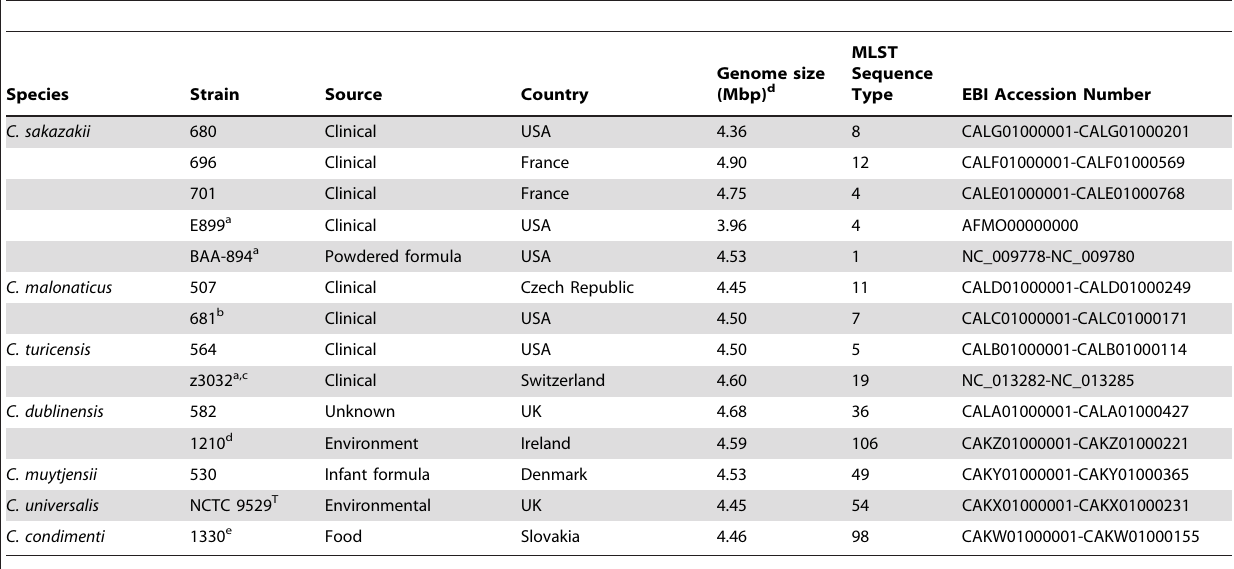
Table 1. Eleven newly assembled and three publicly available Cronobacter genomes analyzed in this study.